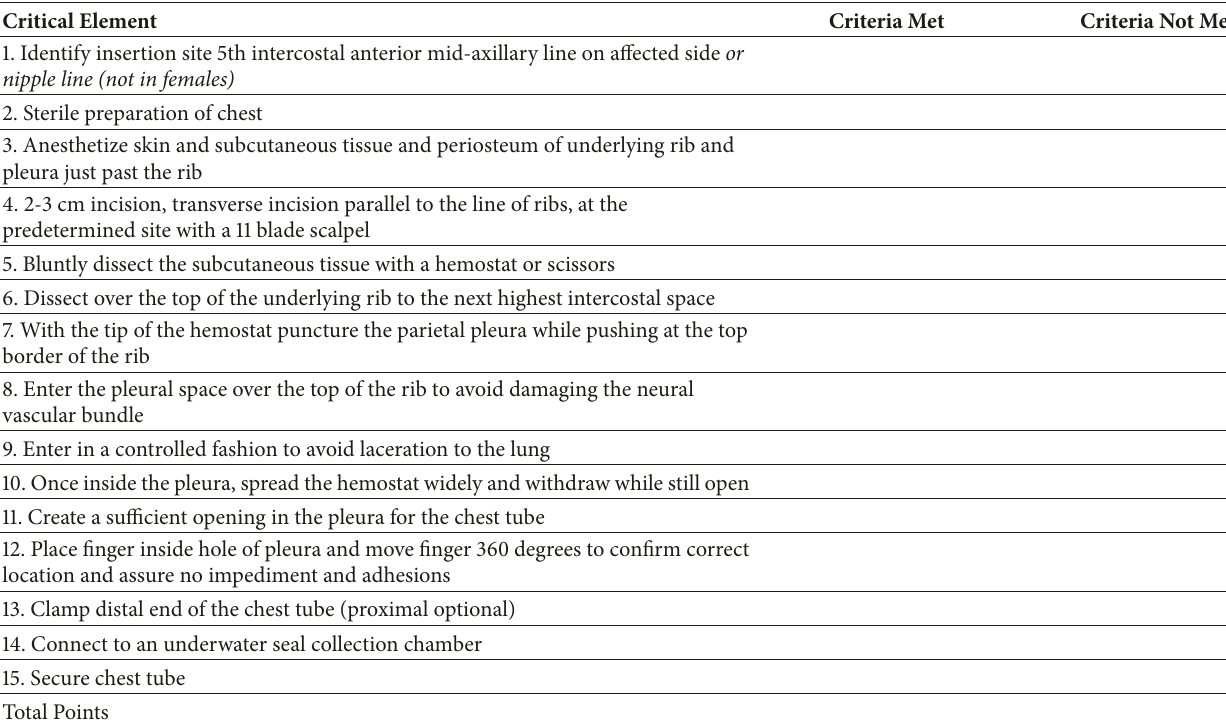
Table 1: Objective assessment checklist of critical steps in chest tube